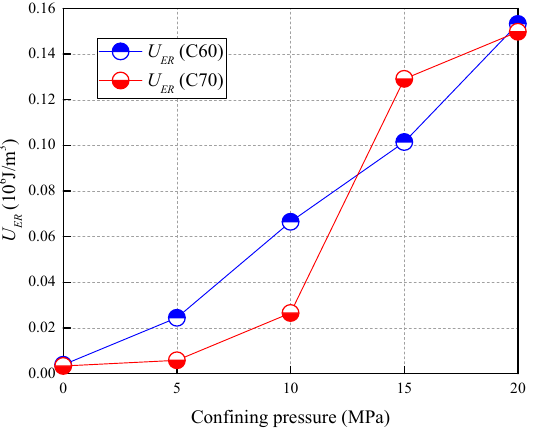
Figure 7. Relationship between confining pressure and final elastic-strain energy density.